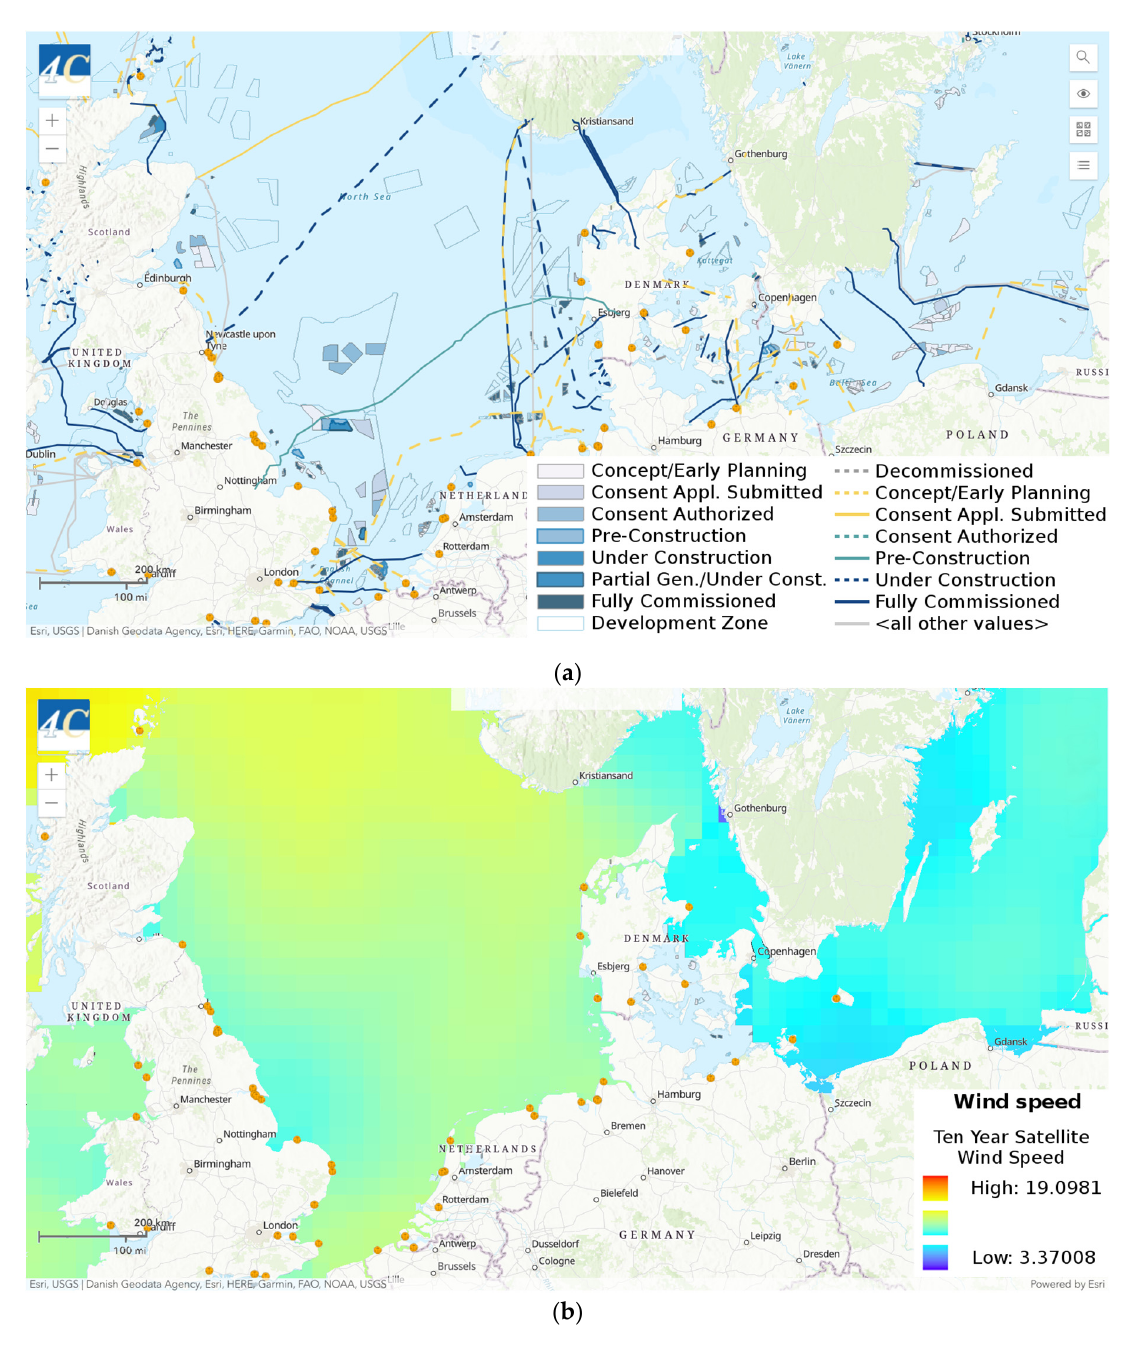
Figure 1. Europe's offshore wind farms: ( a ) location, ( b ) wind conditions [6]. Figure 1. Europe’s o ff shore wind farms: ( a ) location, ( b ) wind conditions